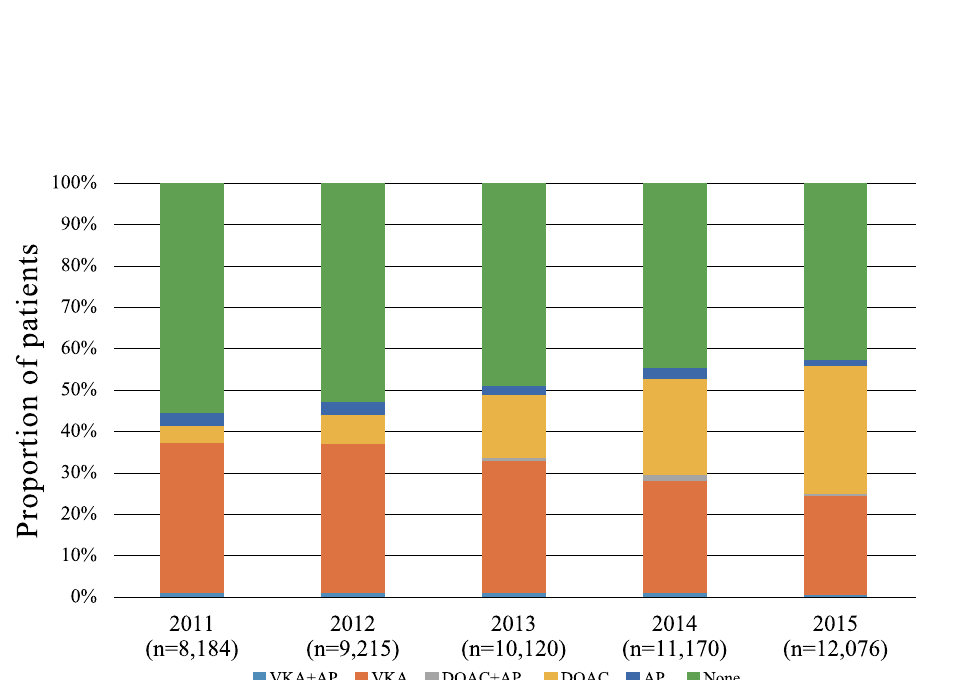
Figure 3. Proportions of prescriptions for anticoagulants and AP among all Af patients. Figure shows time trends in the proportions of prescriptions for anticoagulants and AP among all Af patients aged ≥ 65 years. VKA vitamin K antagonist, DOACs direct oral